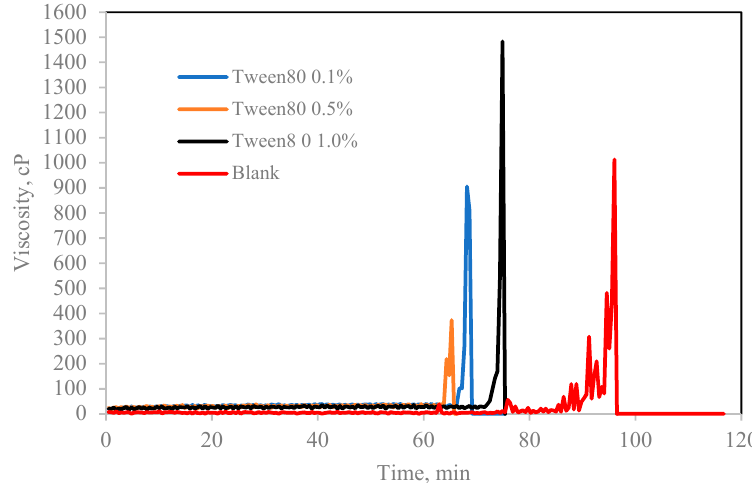
Figure 7. The e ff ect of Tween 80 concentration (% v / v in oil) on cyclopentane hydrate slurry (CP / H2O: Figure 7. The effect of Tween 80 concentration (% v/v in oil) on cyclopentane hydrate slurry (CP/H2O: 50 / 50; aging temperature 2.0 deg C). 50/50; aging temperature 2.0 deg C).